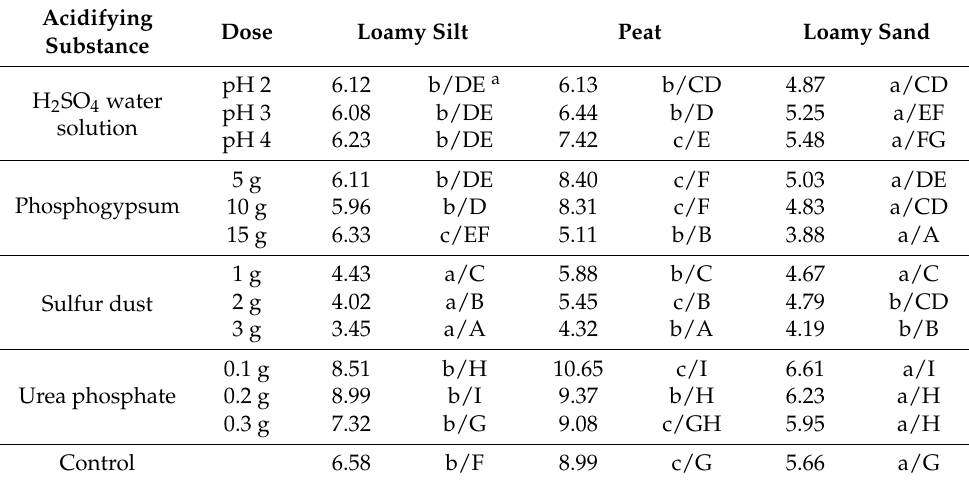
Table 13. Activity of urease activity enzymes in the soil depending on the acidifying substances used after 12 months ( µ mol p-NP